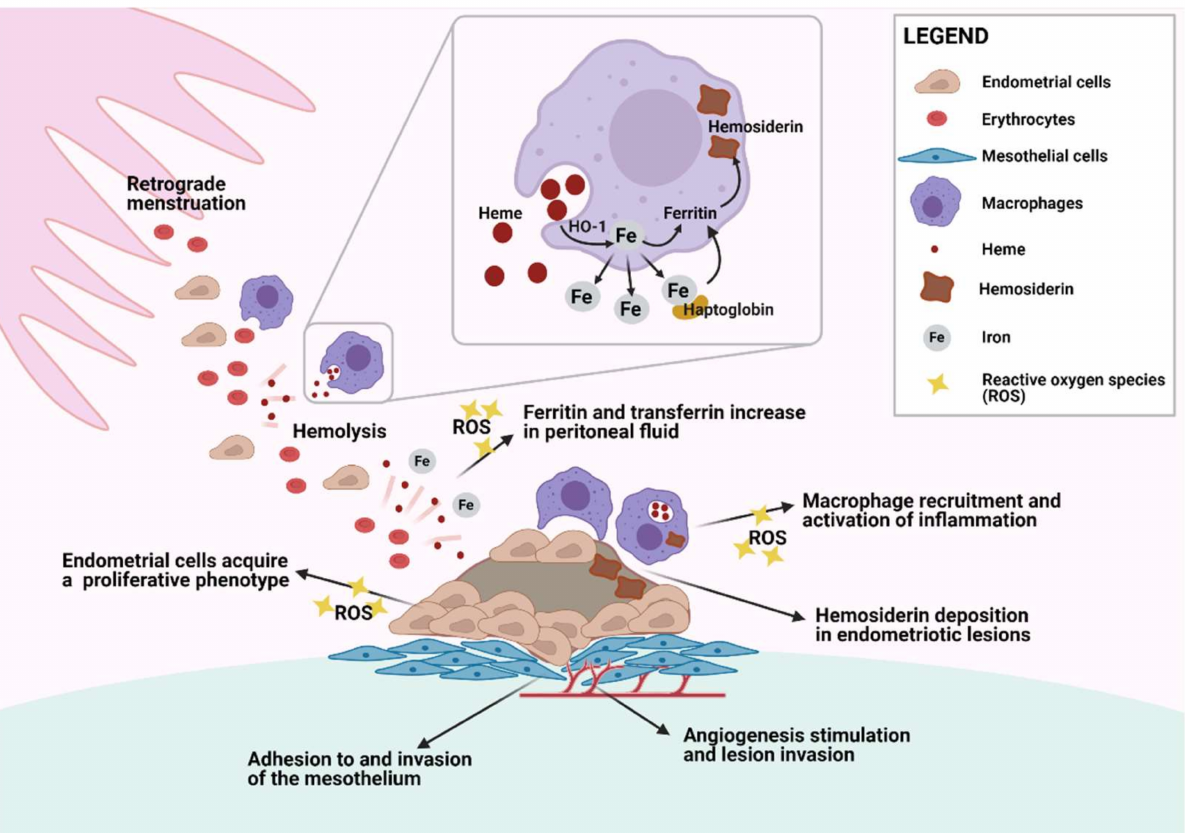
Figure 1. Endometrial cell and macrophage interaction in the pelvic cavity. Erythrocytes and endometrial cells are carried into the pelvic cavity by retrograde menstruation and are phagocytosed by peritoneal macrophages. Heme digestion by heme oxygenase 1 (HO-1) releases iron, which is either stored in the form of ferritin and hemosiderin or released to bind to transferrin. Endometrial cells with adhesive characteristics start to invade the mesothelium and trigger inflammatory signals that recruit more peritoneal macrophages. Local inflammation and increased levels of reactive oxygen species (ROS) contribute to the acquisition of a proliferative phenotype and proangiogenic features that are crucial to endometriotic lesion development. Created with biorender.com (accessed on 29 May